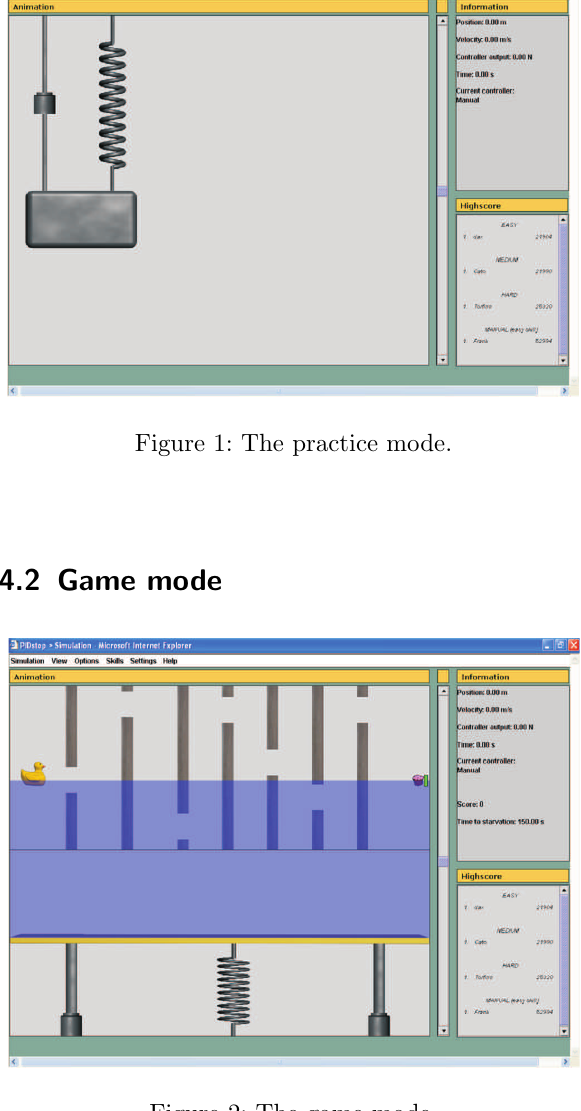
Figure 2: The game